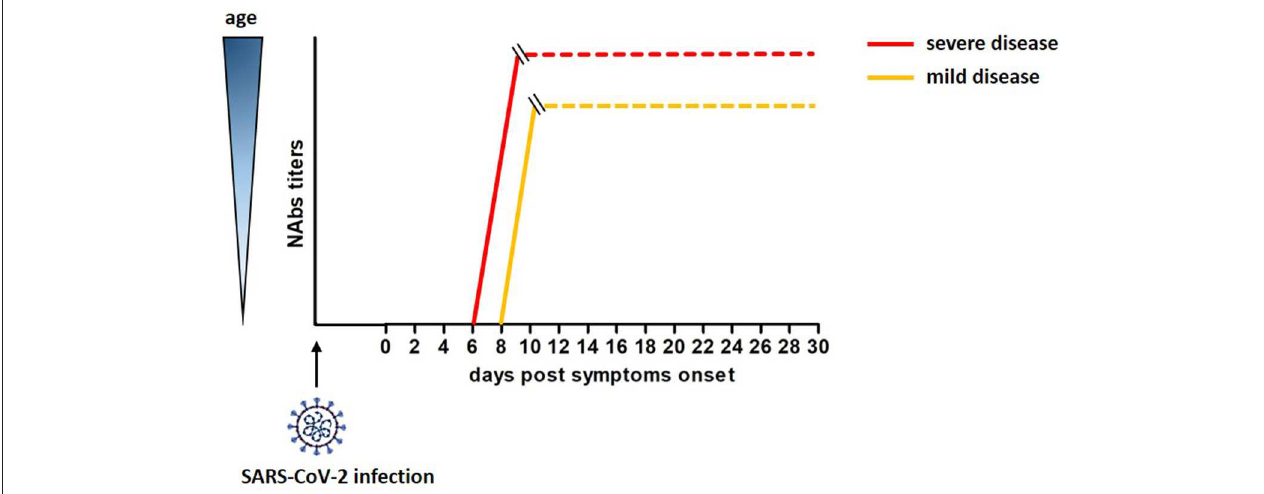
FIGURE 1 | Rough estimate of the development of neutralizing antibodies after SAR-Cov-2 infection and their correlation with age and severity of the disease